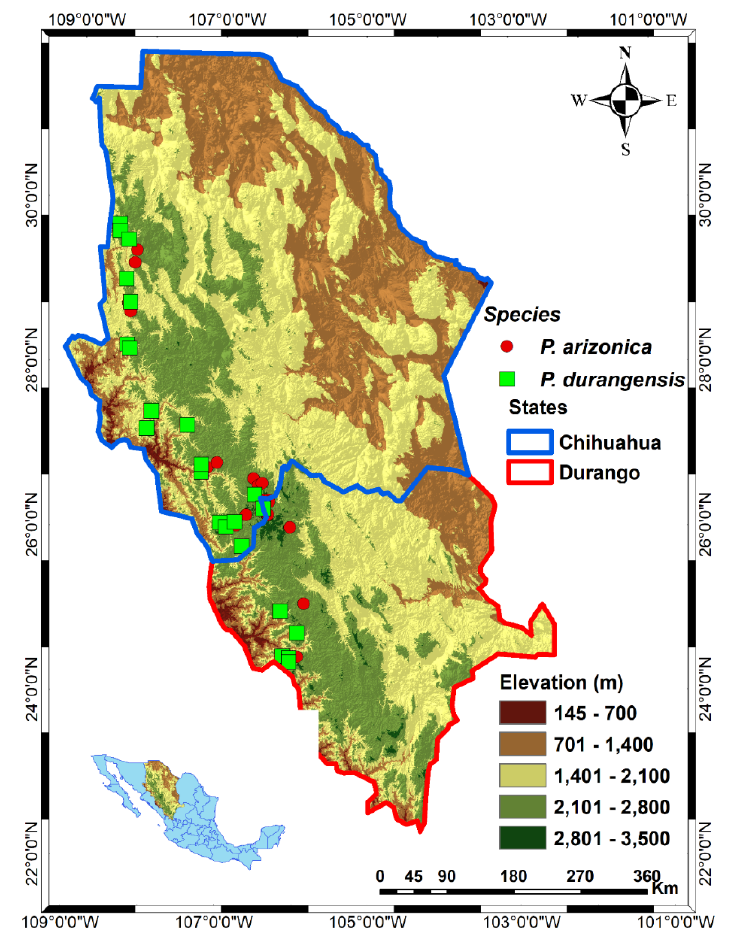
Figure 1. Location of the studied populations of Pinus arizonica and P. durangensis in the states of Chihuahua and Durango, northwestern México.